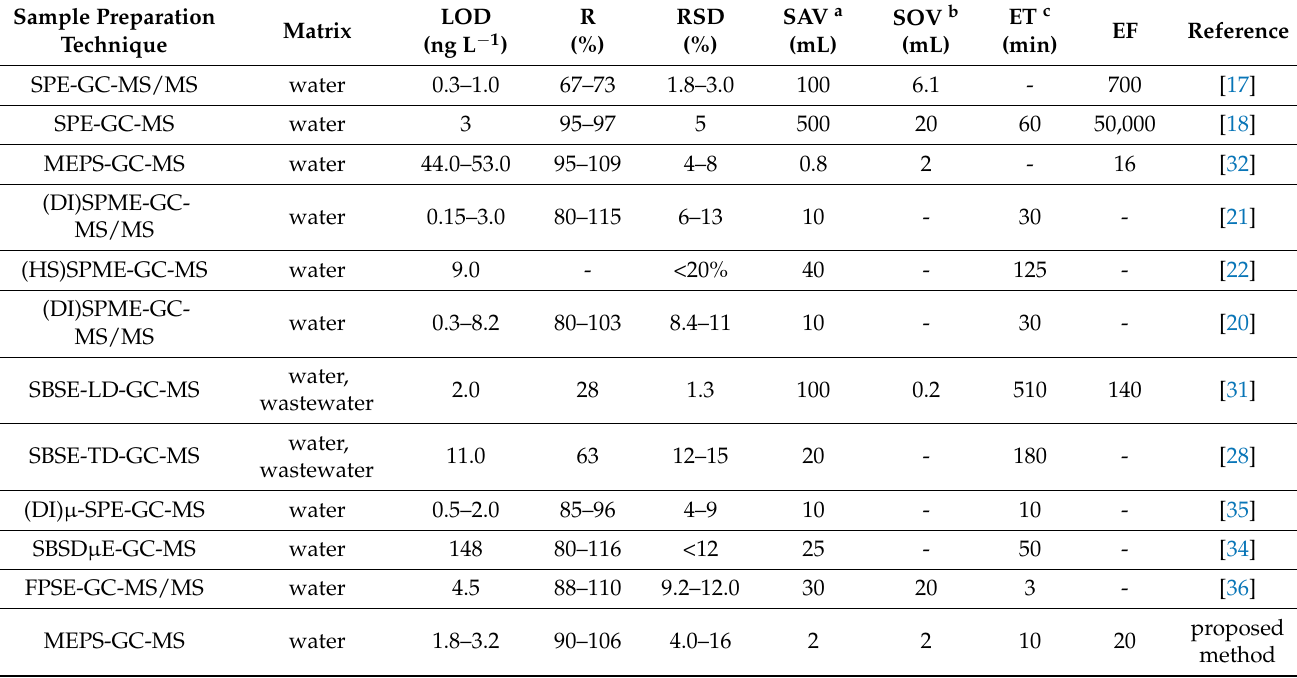
Table 2. Comparison of proposed MEPS-GC-MS method to determine target analytes in water with other analytical methods reported in the